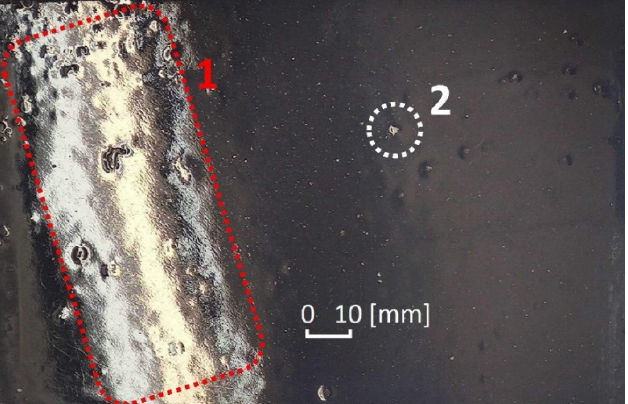
Figure 2. A sample with artificially produced defects; 1—an area with damaged clear coat and 2— flake of the varnish coating.